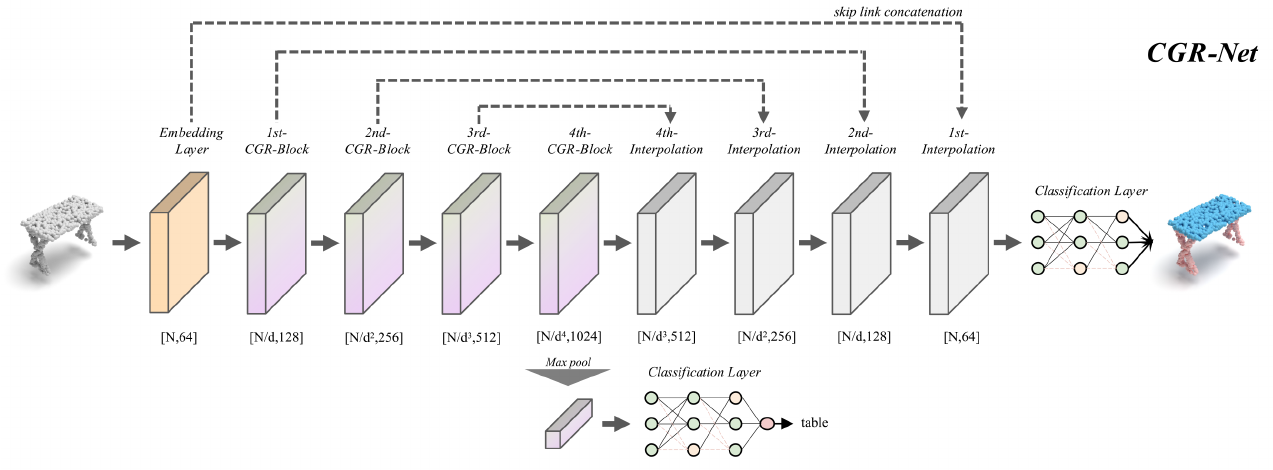
Figure 2. The structure of point cloud classification and segmentation networks constructed by the proposed CGR-block. The number below the module represents the output shape of the current module. “ d ” denotes the decimation ratio of each